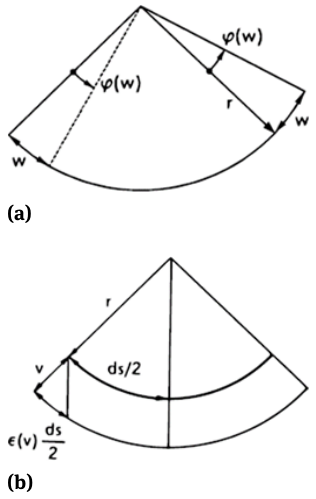
Figure 6: Beam with curvilinear axis: rigid rotation to be subtracted from the total one and due to a uniform tangential displacement (a); additional axial dilation due to a uniform radial displacement (b)